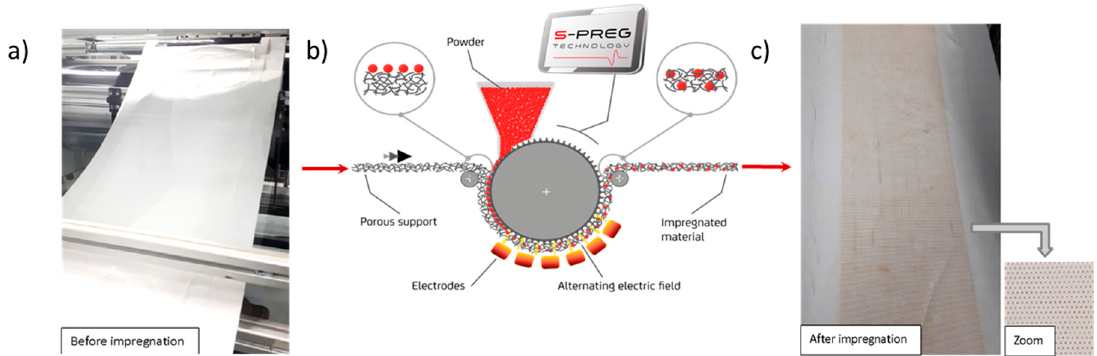
Figure 2. ( a ) Pullulan electrospun mesh being inserted into the pilot equipment for dry impregnation. ( b ) Sketch of the dry impregnation technology (S-Preg). ( c ) Pullulan electrospun mesh impregnated with CLA complexes .